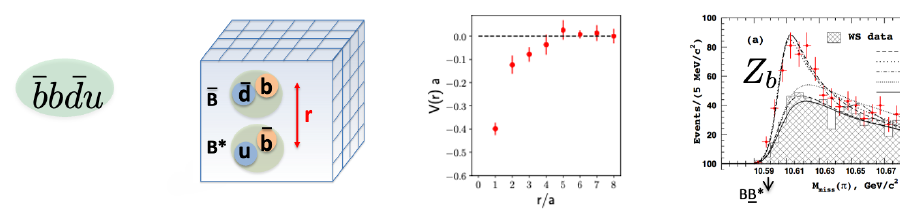
Figure 7. The static potential between B and ¯ B ∗ is attractive [30] and is likely responsible for the existence of Z b (cid:39) ¯ bb ¯ du